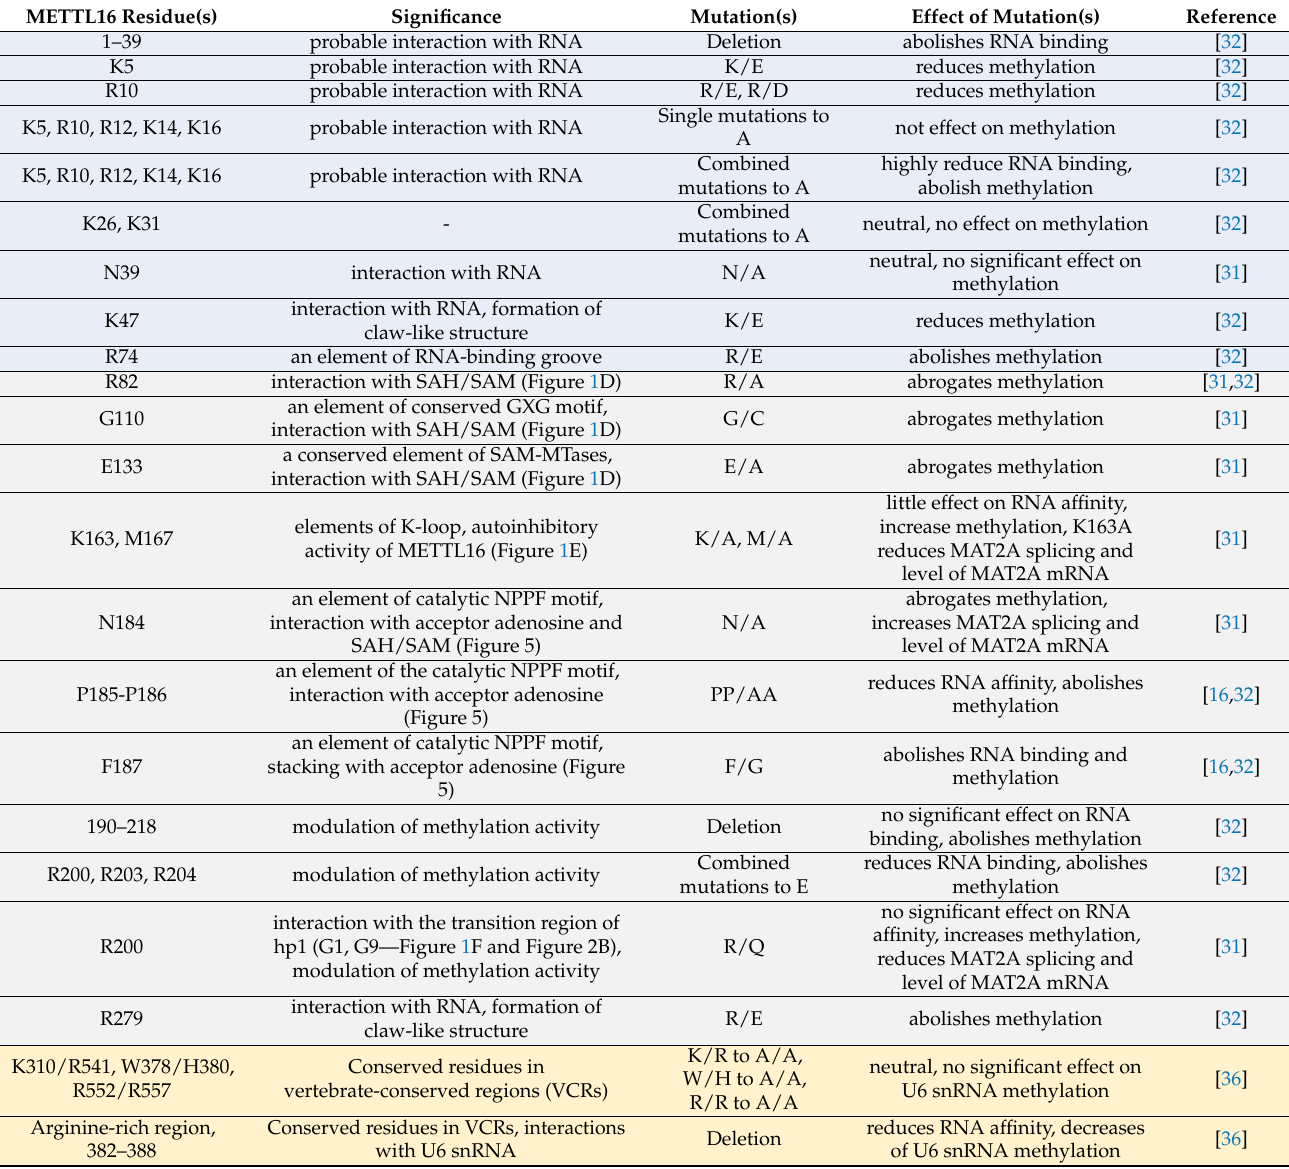
Table 1. Significance of METTL16 residues. Blue indicates residues within the N-terminus (1–78), gray indicates residues within the Rossmann fold (79–288), yellow indicates residues from the C-terminal domain. METTL16